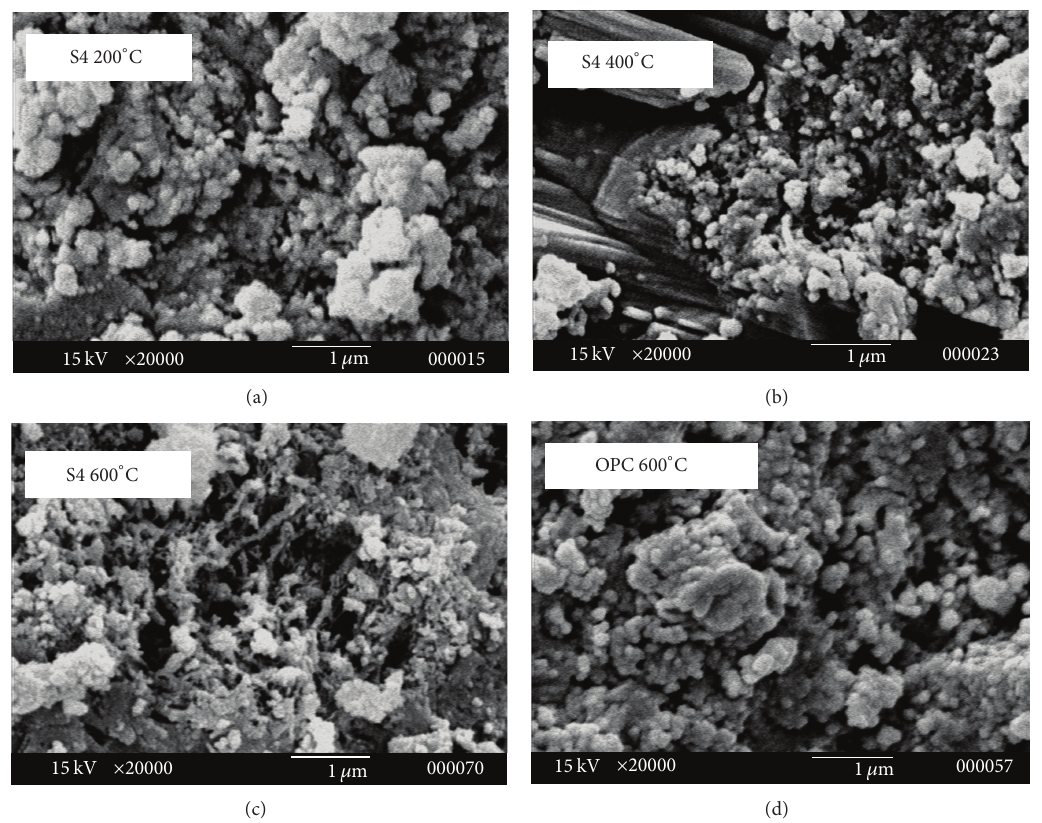
F 11: e SEM micrographs of sewage sludge ash blended cement paste (S4) �red at 200–800